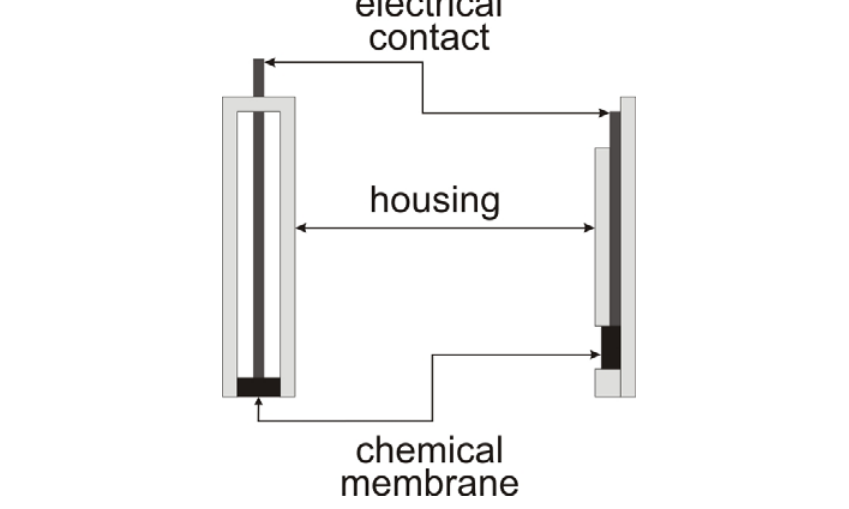
Figure 2. A conventional ion-selective electrode structure (left) in comparison with a structure of the screen-printed planar sensor